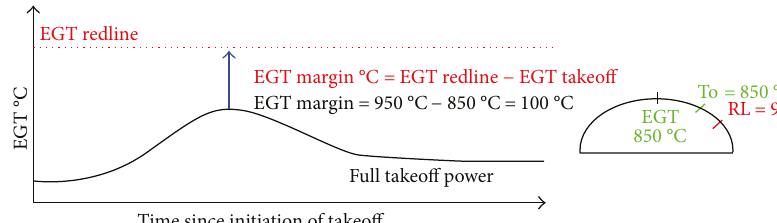
Figure 3: EGT margin.